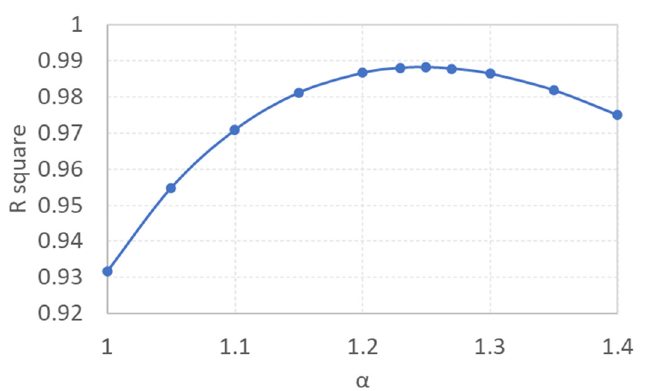
Figure 3. R square versus α for Model 2 in Figure 2a. When α = 1, there is no surface roughness considered, and it is equivalent to Model 1. When α = 1.25, R square gets its maximum value of 0.9882.